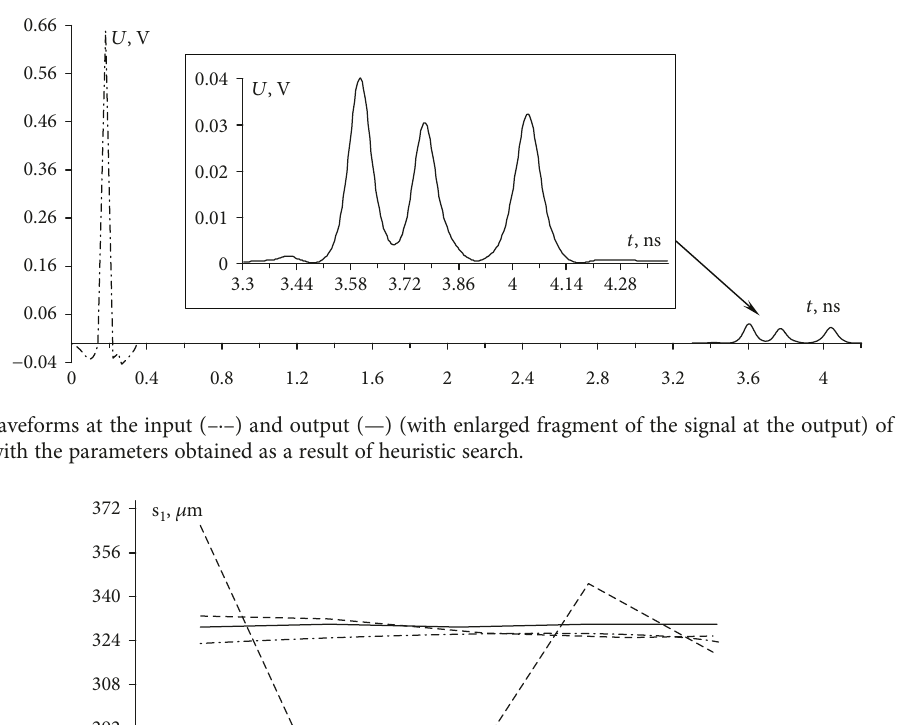
value for the number of individuals and generations: 3 and 10 ( – – ); 10 and 10 ( ⋯ ); 10 and 1